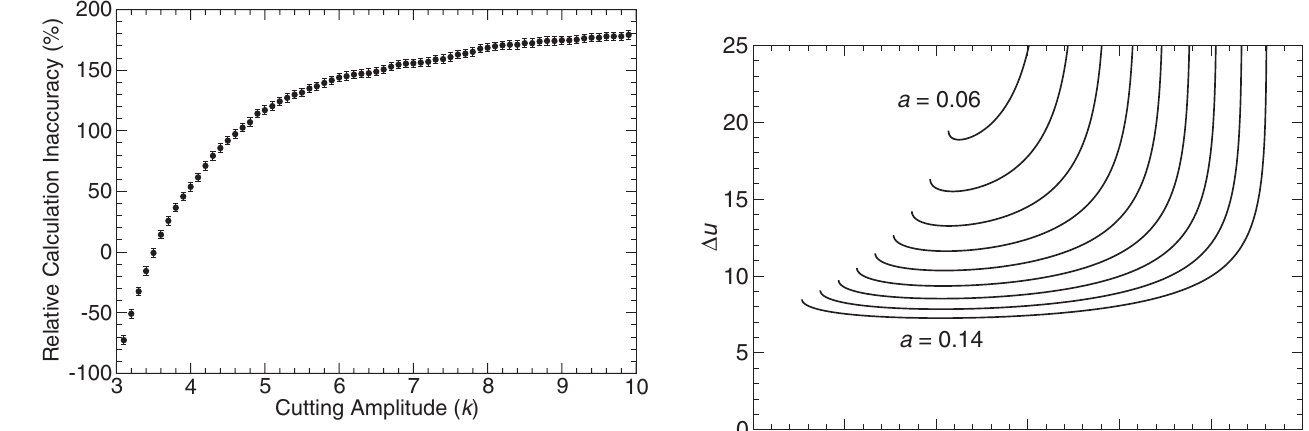
FIG. 14. Relative inaccuracy in the calculation of the emit- tance growth (cid:1) (cid:4) vs cutting amplitude k , for a (cid:2) 0 : 10 and a desired emittance growth of 10%. Error bars show 1 (cid:6) uncer- tainties due to the finite number of particles.